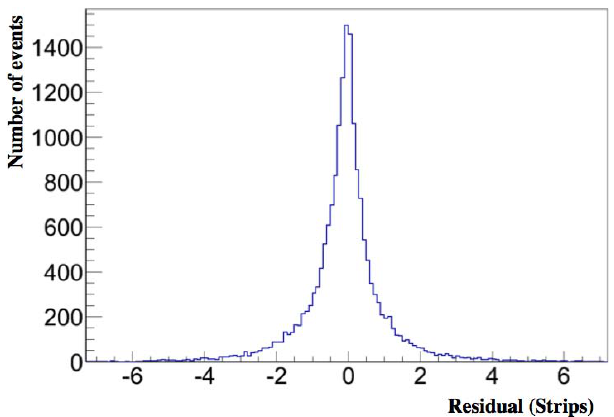
Fig. 4. Distribution of the residuals (X estimated − X hit ) for one of the layers. The x-axis is measured in 1.5-mm strips.